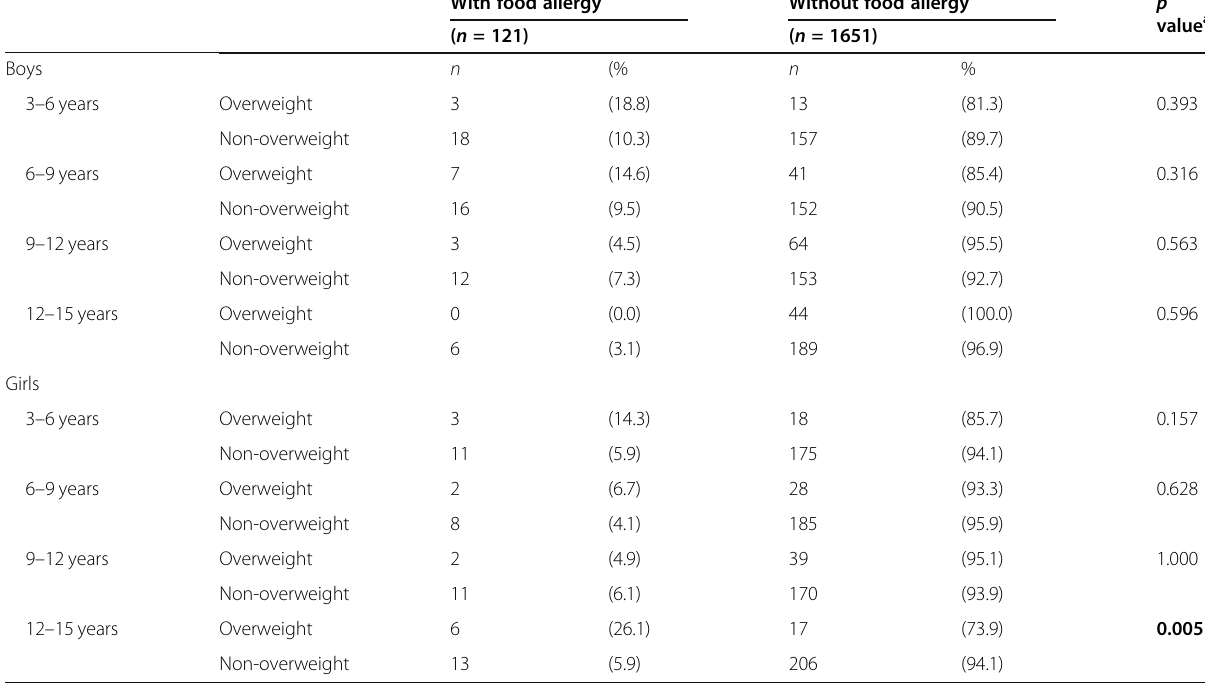
Table 4 The difference in the prevalence of food allergy between overweight and non-overweight by gender and age groups With food allergy Without food allergy